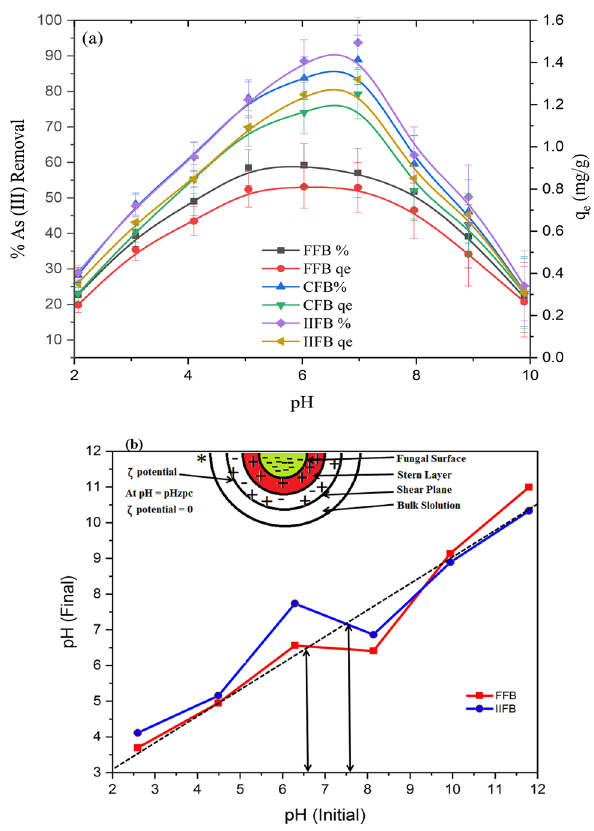
Figure 2. ( a ) Effect of pH on As(III) biosorption over FFB, CFB and IIFB; ( b ) Initial pH vs final pH plot for determination of pH ZPC of FFB and IIFB by solid addition